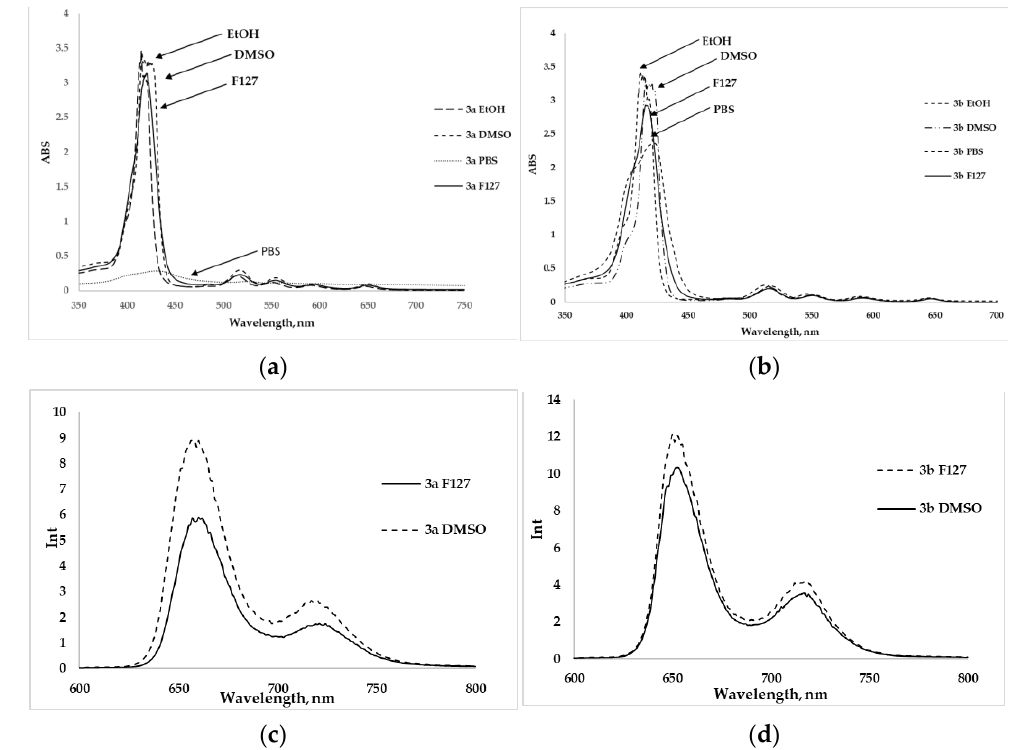
Figure 3. Electronic absorption spectra of compounds 3a ( a ) and 3b ( b ) (10 − 6 M) and fluorescence spectra in DMSO and Pluronic F-127 at the excitation λ ex = 415 nm for the compounds 3a ( c ) and 3b ( d ) (10 − 6 M).